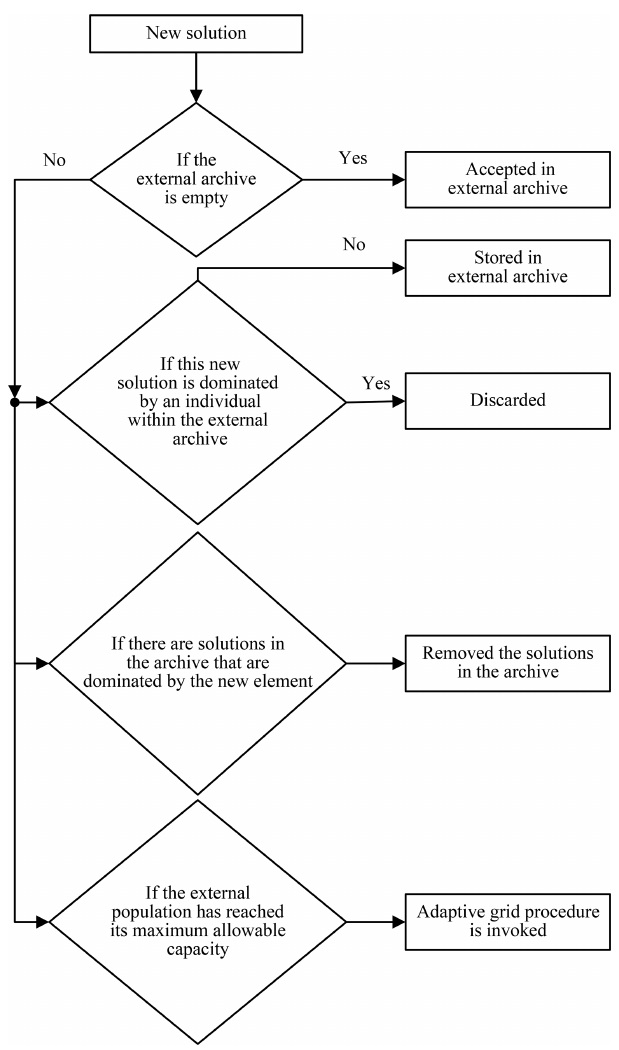
Figure 4. The maintenance process of external